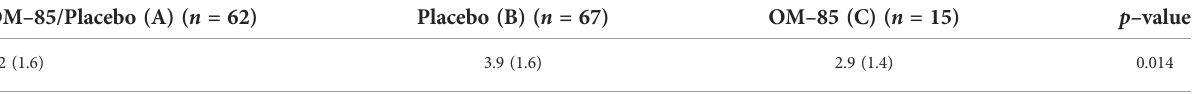
TABLE 1 Mean (SD) age in years at T0 per randomization group (A, OM – 85/placebo, B, placebo, C, OM – 85) of all patients with available stool specimens and gut microbiota analysis ( n = 144). OM – 85/Placebo (A) ( n =